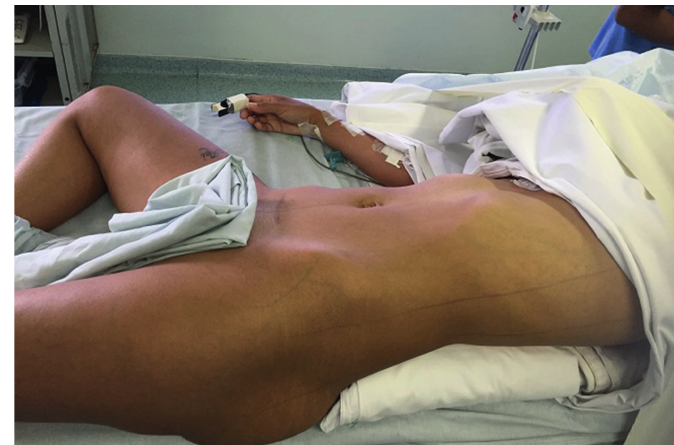
Figure 2 - valdivia position.